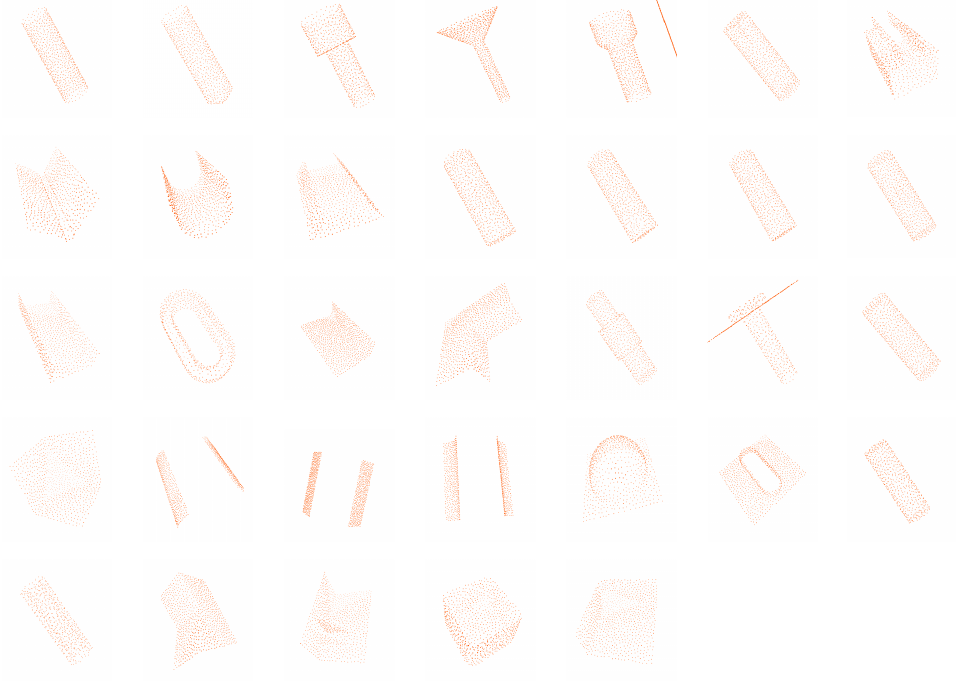
Figure A4. The 256-point sampling models of